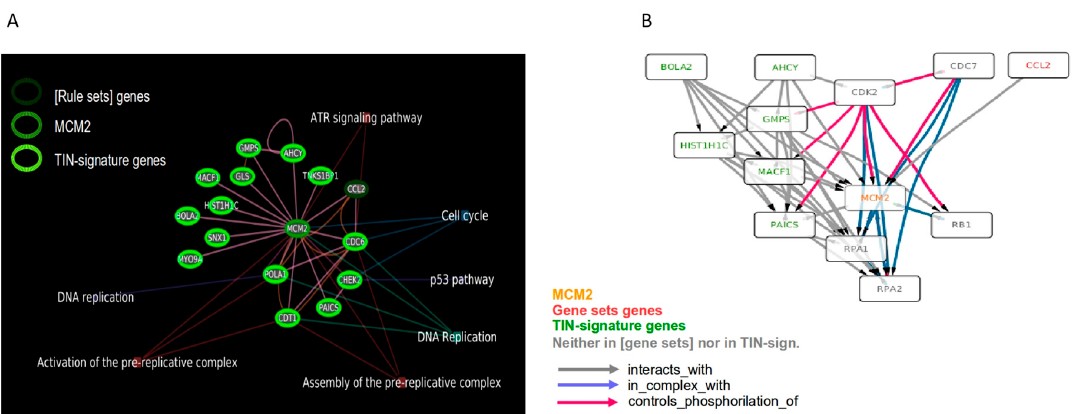
Figure 4. Gene interaction analyses. ( A ) The panel shows the MCM2 direct interactors identified by the EGAN software using KEGG, NCI-Nature Pathway Interaction Database, Panther, and Reactome as connections sources; the most relevant enriched pathways are also shown. Most of the interactors are listed in the Transcriptional Instability (TIN)-signature genes. ( B ) Pathway Commons gene interactions ‘core’ derived from the genes shortlisted in panel A. The more interconnected genes are shown revealing, besides (rule sets) and TIN-signature genes, other interactors including RPA1 and RPA2.